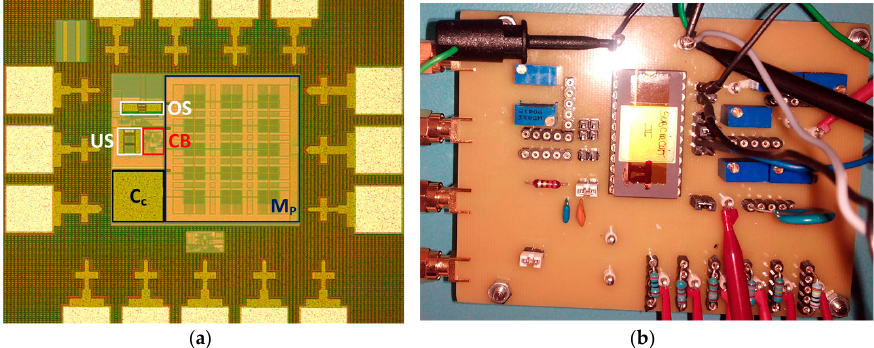
Figure 6. ( a ) Detail of the integrated LDO regulator (CB: Core (without M P ) + Bias); and ( b ) LDO PCB test. PCB